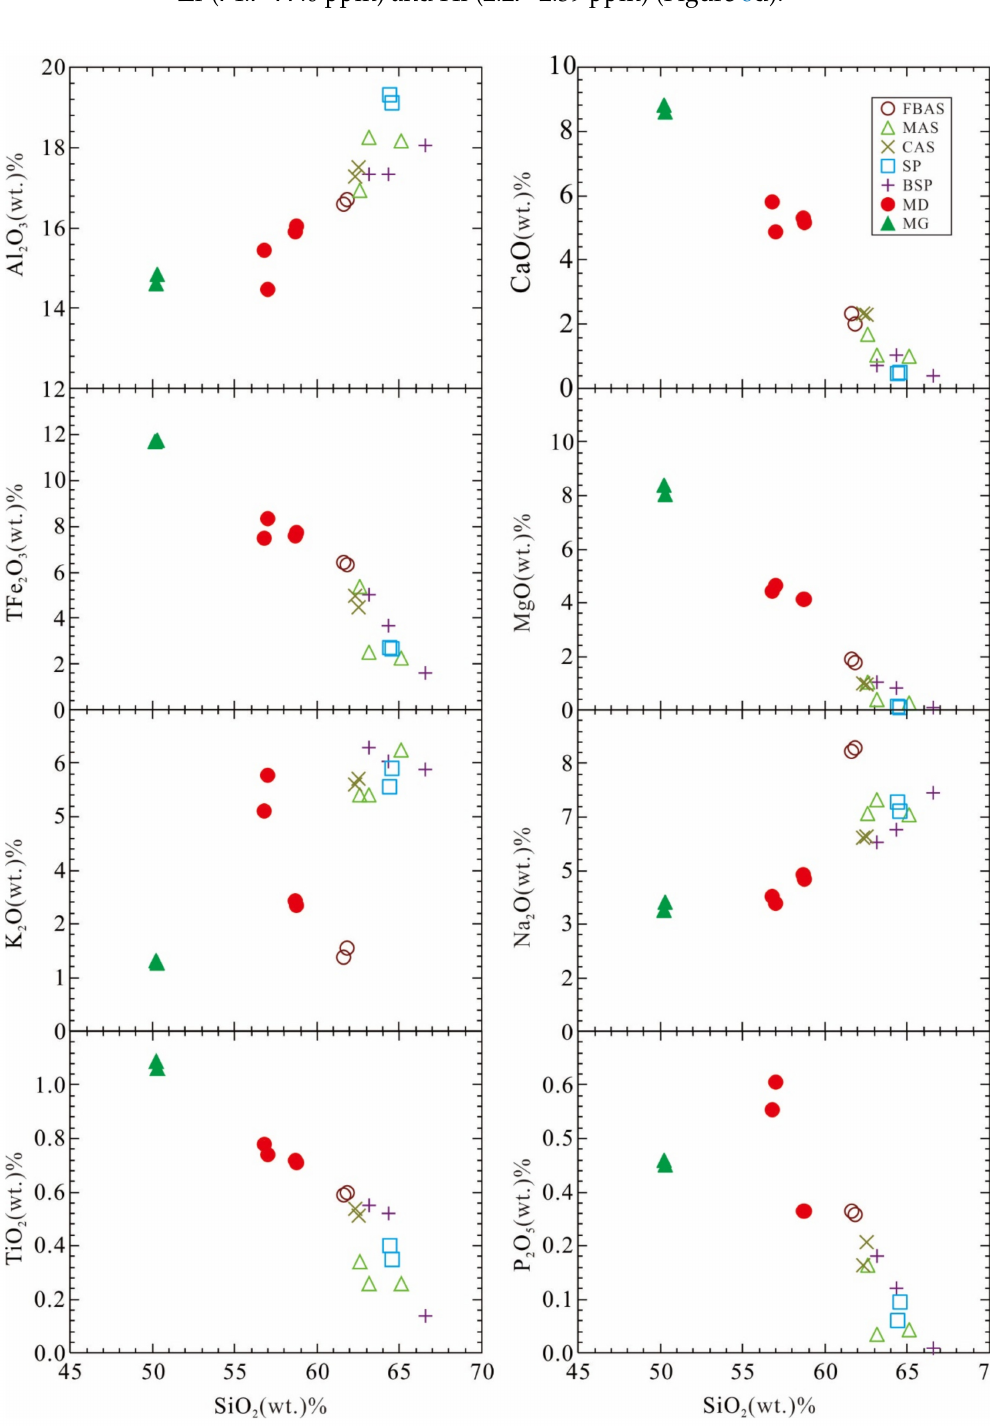
Figure 9. Harker diagrams for the Hongshan